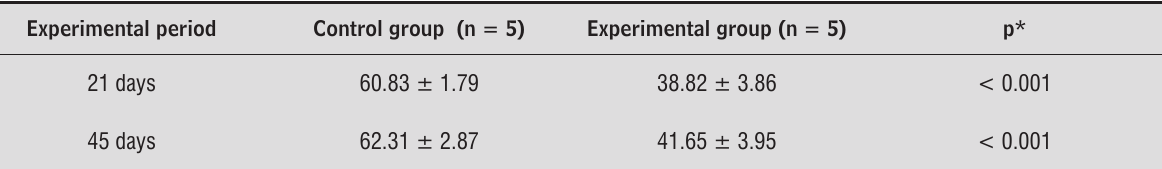
Table 1 - Average and standard deviation of the transverse section area (in micrometers) of the analyzed fibers from the soleus muscle from the analyzed animals (groups: control and experimental) and value of p Experimental